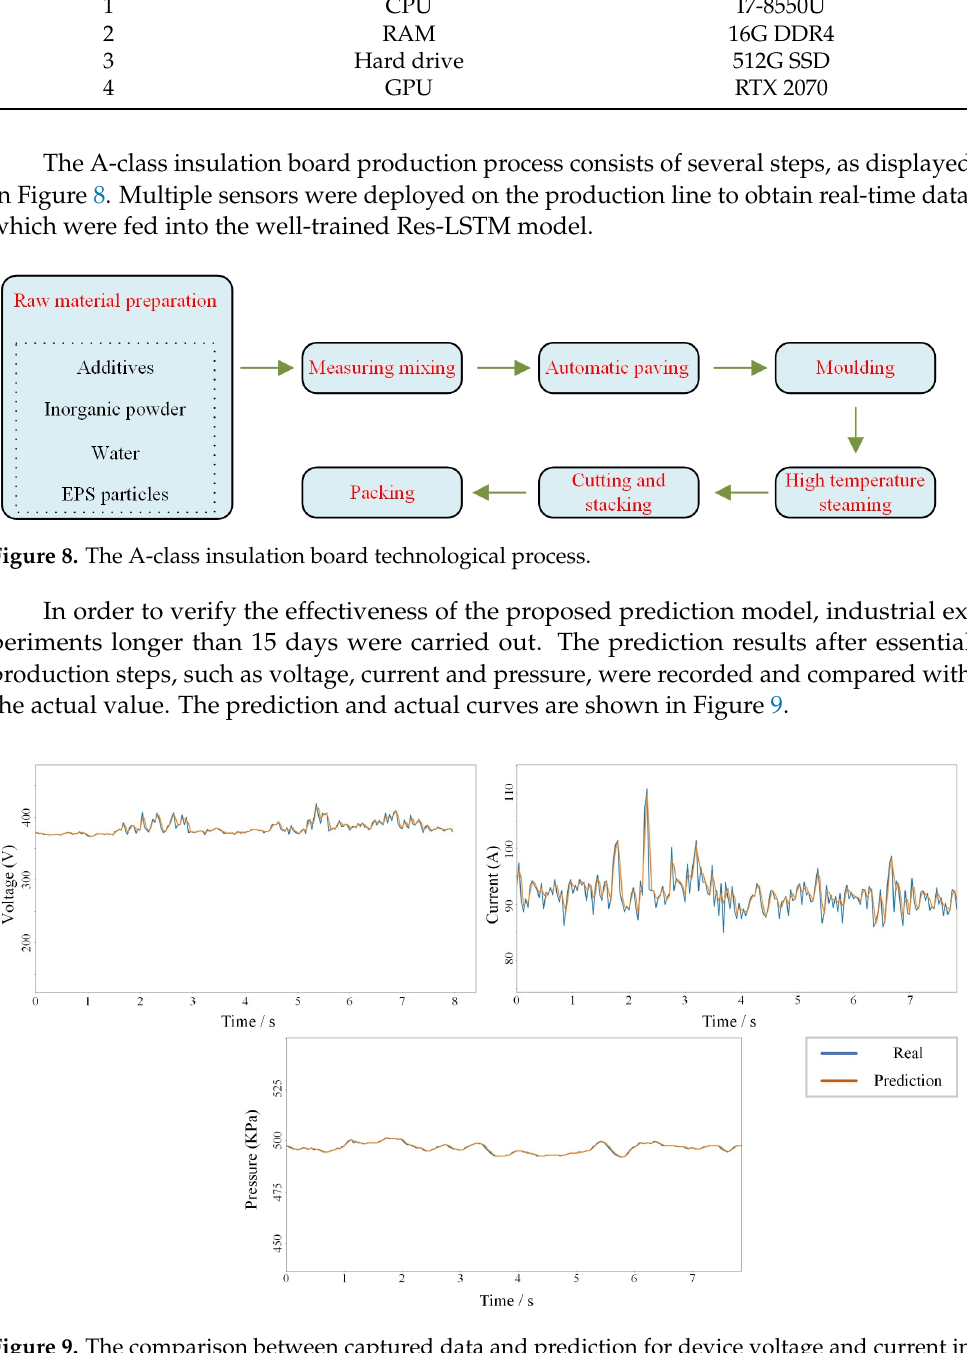
Figure 9. The comparison between captured data and prediction for device voltage and current in one node.